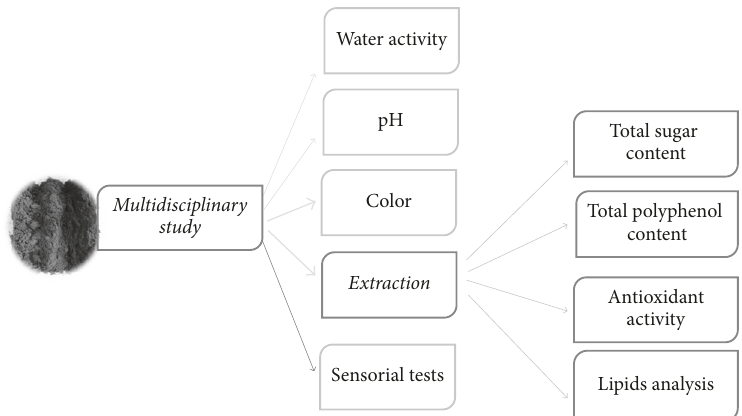
Figure 2: Multidisciplinary study of roasting carob pulp.